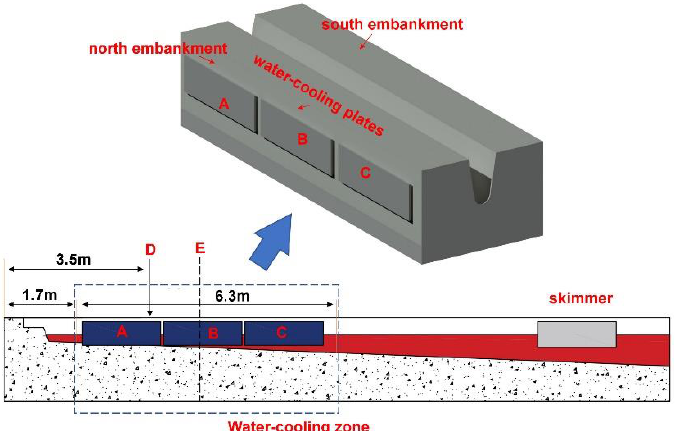
Figure 2. Illustration of the installation pattern of the water cooling device on the trough (A, B, and C: the three water-cooling plates on the north embankment of the trough; D: the measured plane on the trough; and E: the selected plane for modeling)